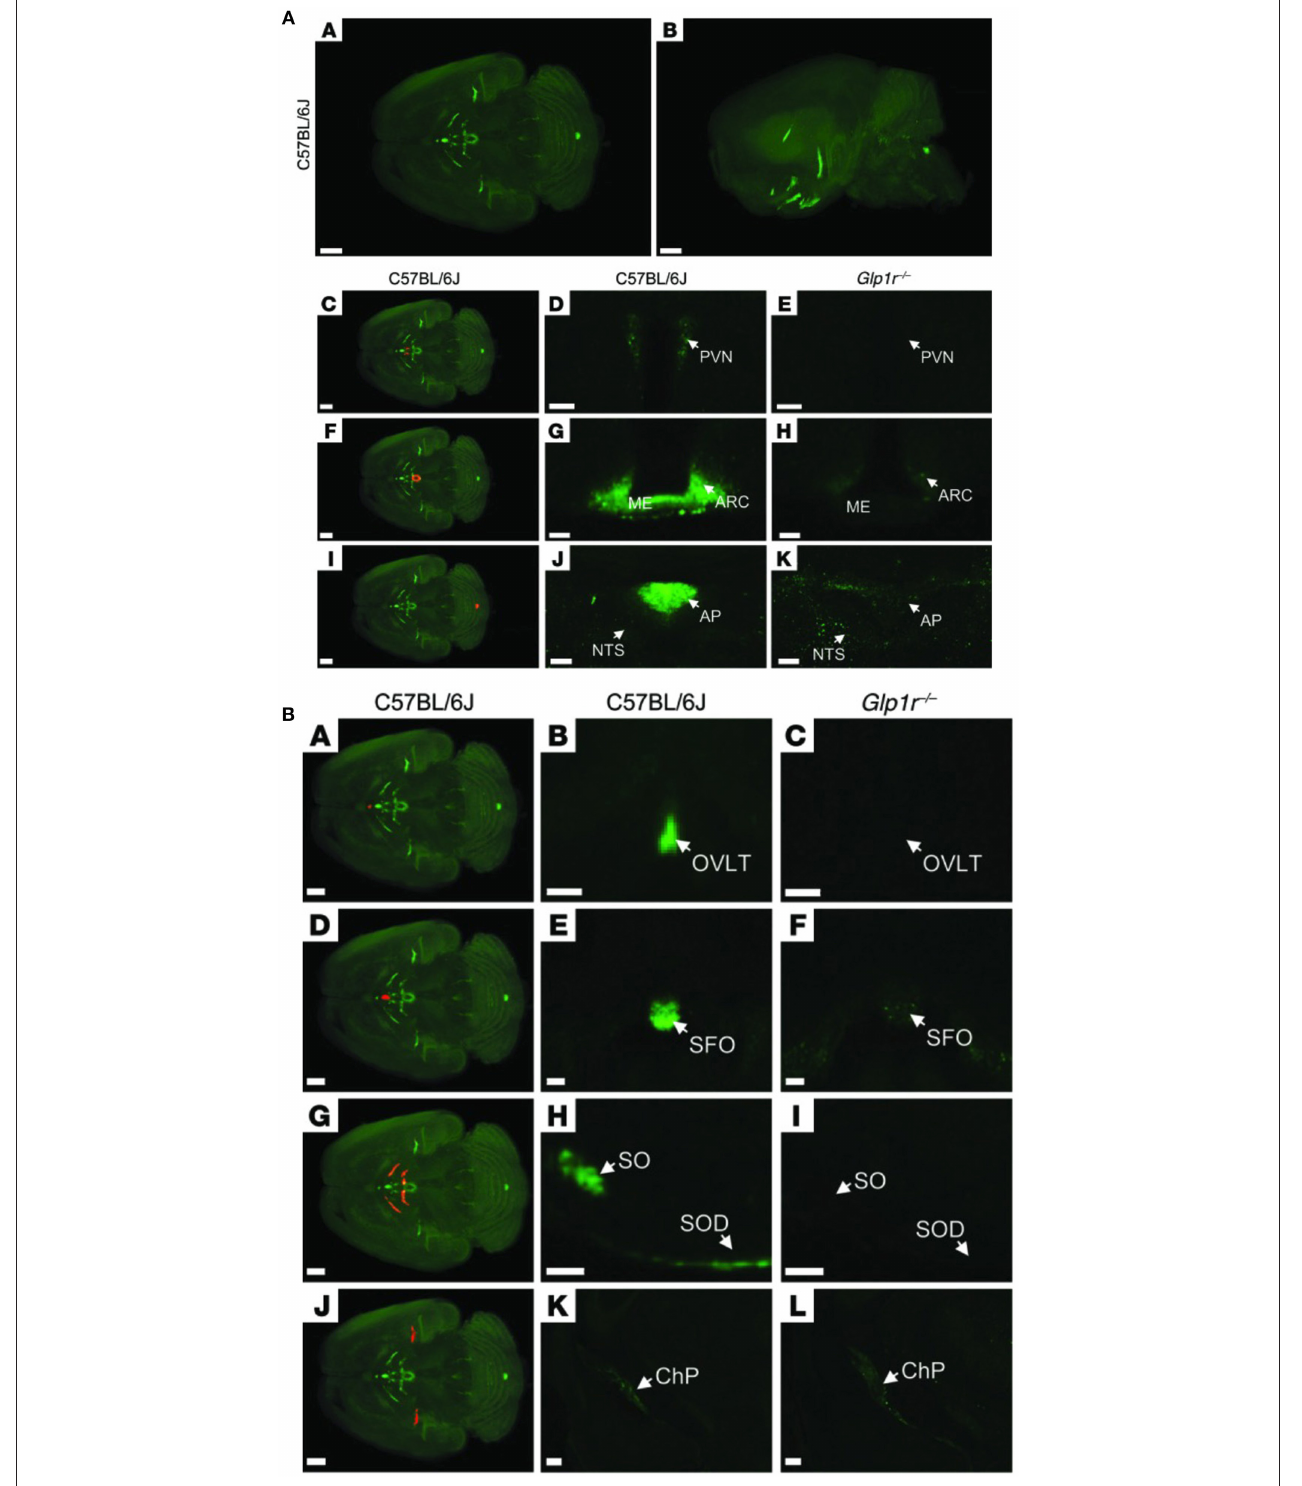
FIGURE 7 | Distribution of fluorescently labeled liraglutide in the mouse brain. (A) Representative whole brain images viewed in the (A) dorsoventral or (B) sagittal plane from C57BL/6J mice administered with liraglutide 750 . The brain tissue was scanned at 620 and 710nm, representing both autofluorescence from the tissue (gray) and specific signal (green). The red regions in (C,F,I) are shown at higher magnification in (D,G,J), respectively. Images in (D,E,G,H,J,K) show high-magnification